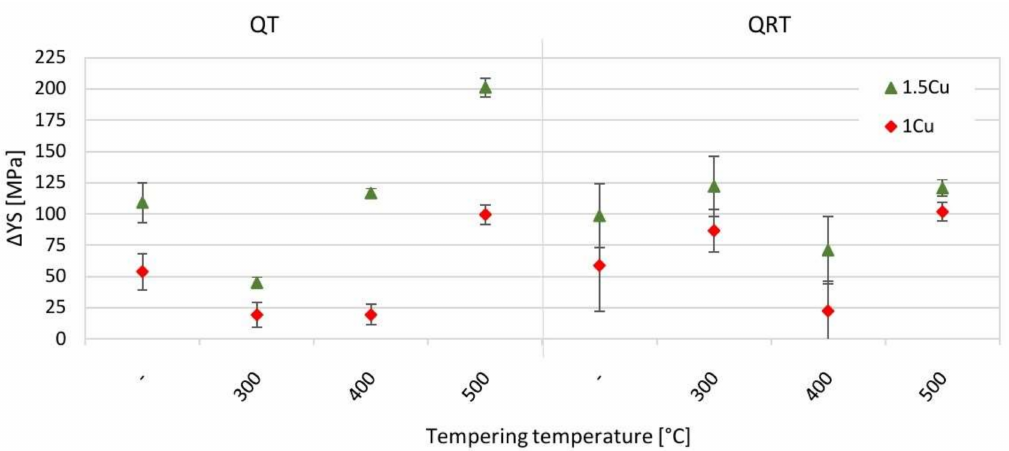
Figure 8. Di ff erence ∆ YS between the YS of Cu-alloyed materials and 0Cu samples tempered for 60 min. YS of 0Cu samples is the zero-line.